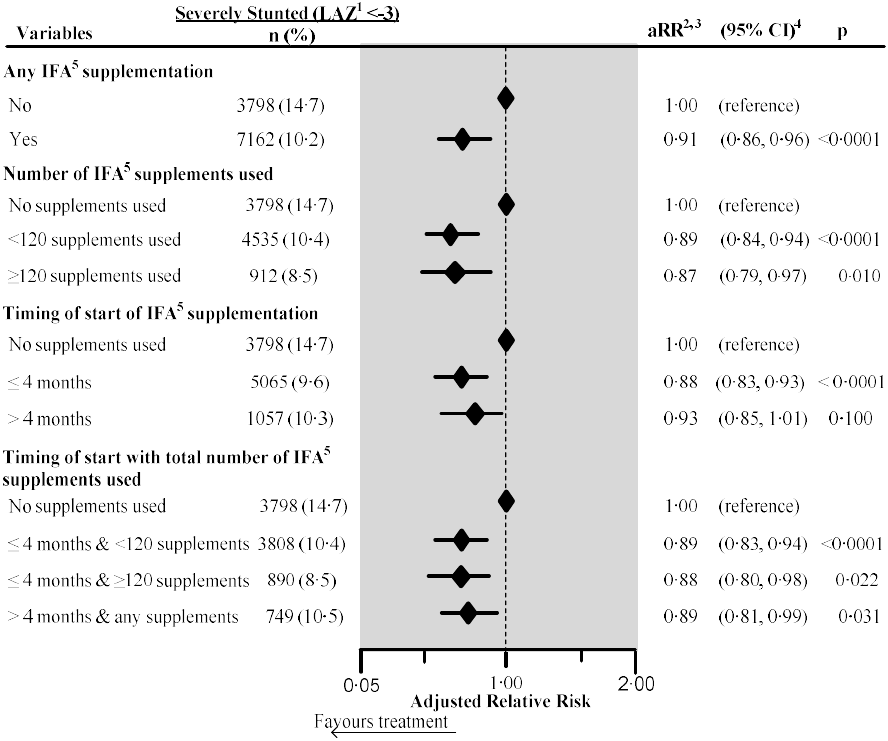
Table 8. Effect of any iron/folic acid (IFA) supplementation, the number of supplements used, the timing of the start of supplements and a combination of the timing of start with the number of supplements used on the length-for-age Z score in south Asian children <2 years old, adjusted linear regression 1 .